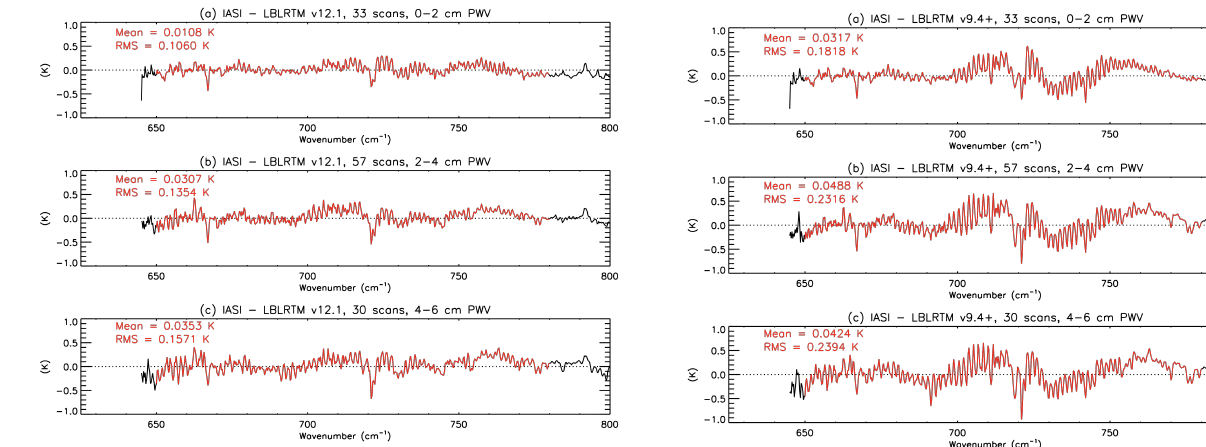
Fig. 6. Mean final (a posteriori) brightness temperature residuals in the CO 2 ν 2 band using LBLRTM v9.4 + as in Fig. 3c, but only for profiles with (a) 0 to 2cm, (b) 2 to 4cm, and (c) 4 to 6cm of precipitable water vapor